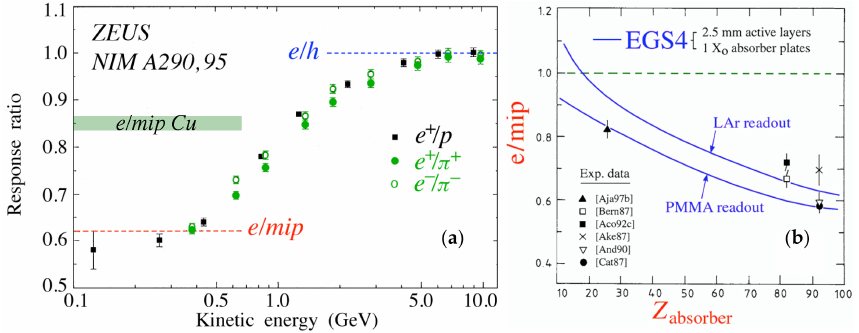
Figure 2. The low-energy response of the compensating ZEUS calorimeter ( a ) and the e / mip values measured for sampling calorimeters with different Z absorber material ( b